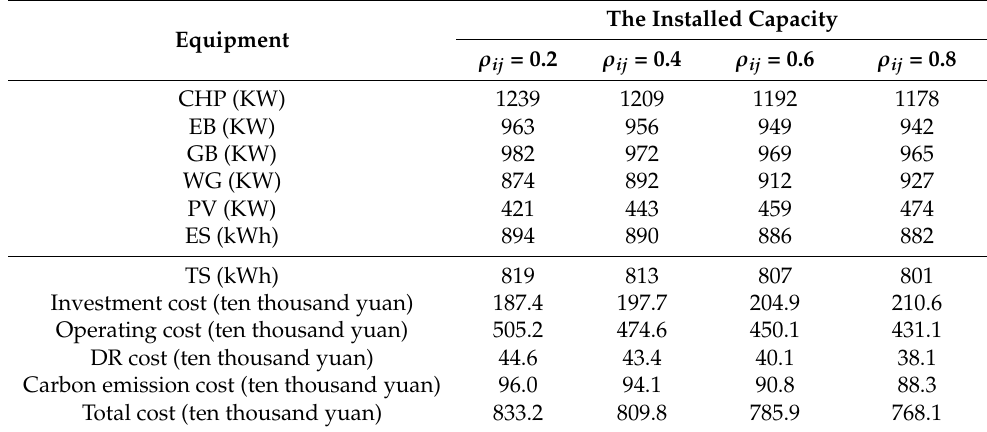
Table 5. Optimization results under different correlation coefficient.